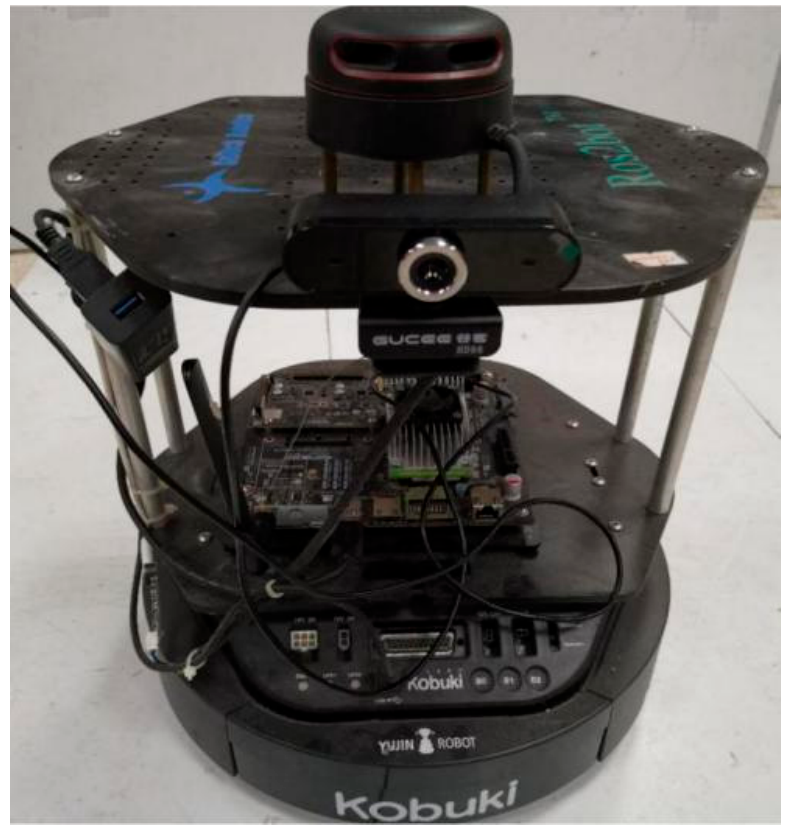
Figure 10. Robot platform and related